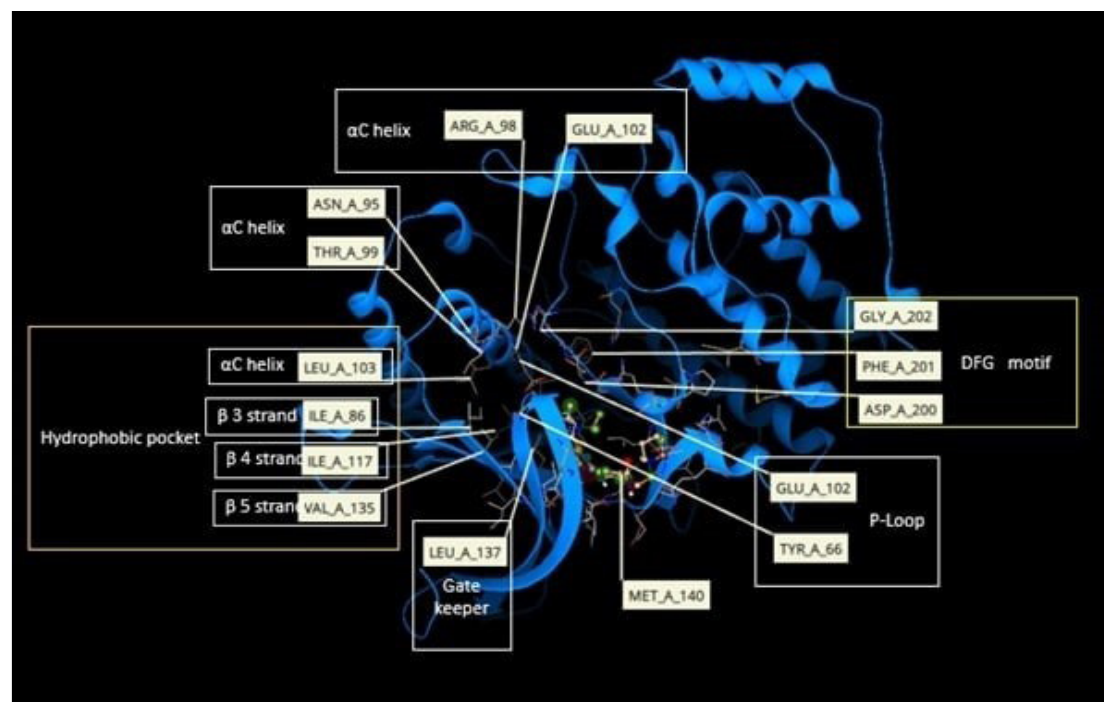
Figure-IV: The allosteric binding site depicted by the p-loop and αC helix. Figure-IV shows the active amino acid residues in the allosteric binding site of ERK5.